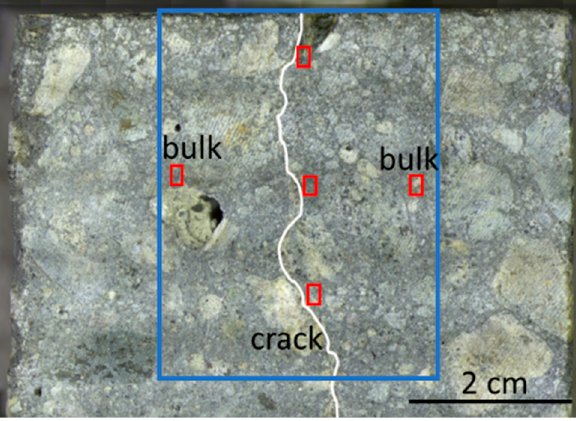
Figure 2. Illustration of positions for the SEM-EDX point analysis in the bulk and close to the crack (red rectangles). The blue rectangle illustrates the area of the thin section used for Scanning electron microscopy energy dispersive (SEM-EDX) analysis and optical polarizing microscopy.